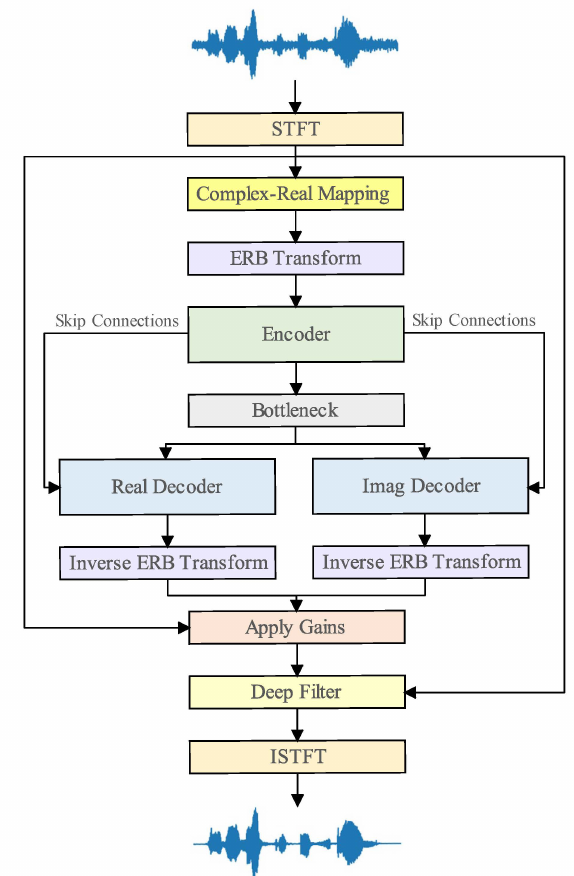
Figure 1. The overall architecture of FLSTN.